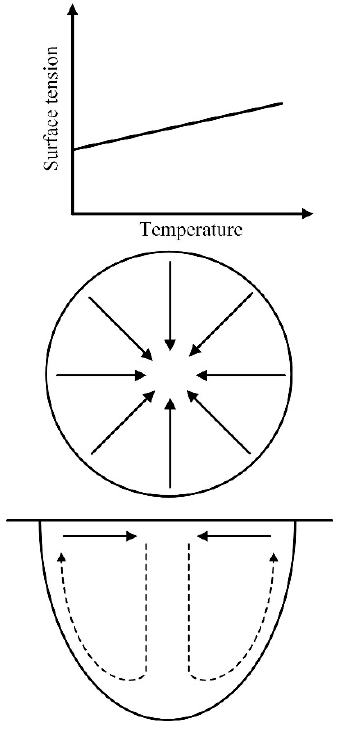
Figure 5. Relation between surface tension distribution and liquid metal flow of the molten pool.